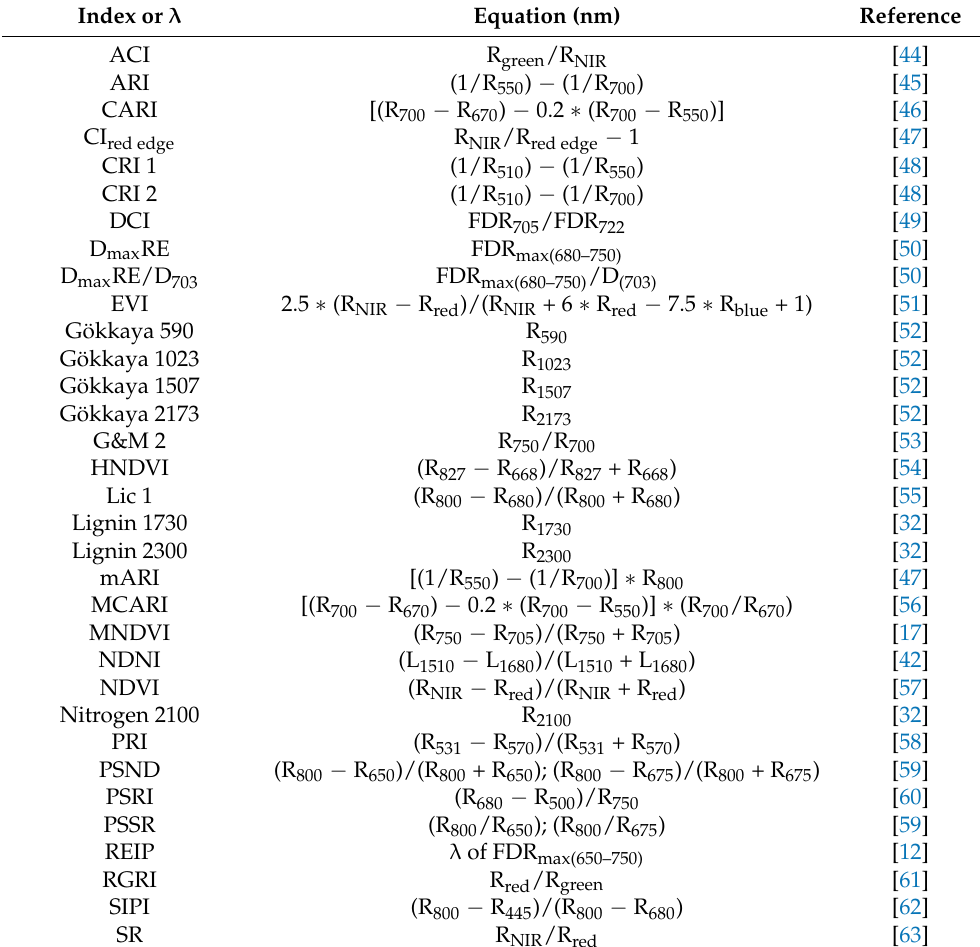
Table 1. Vegetation indices and wavelengths of interest included in a best subsets approach to building multiple linear regression models for the prediction of natural abundance foliar δ 15 N from hyperspectral data in Douglas-fir and loblolly pine. R = reflectance, FDR = 1st derivative of R, L = log of 1/R, FDL = 1st derivative of the log of